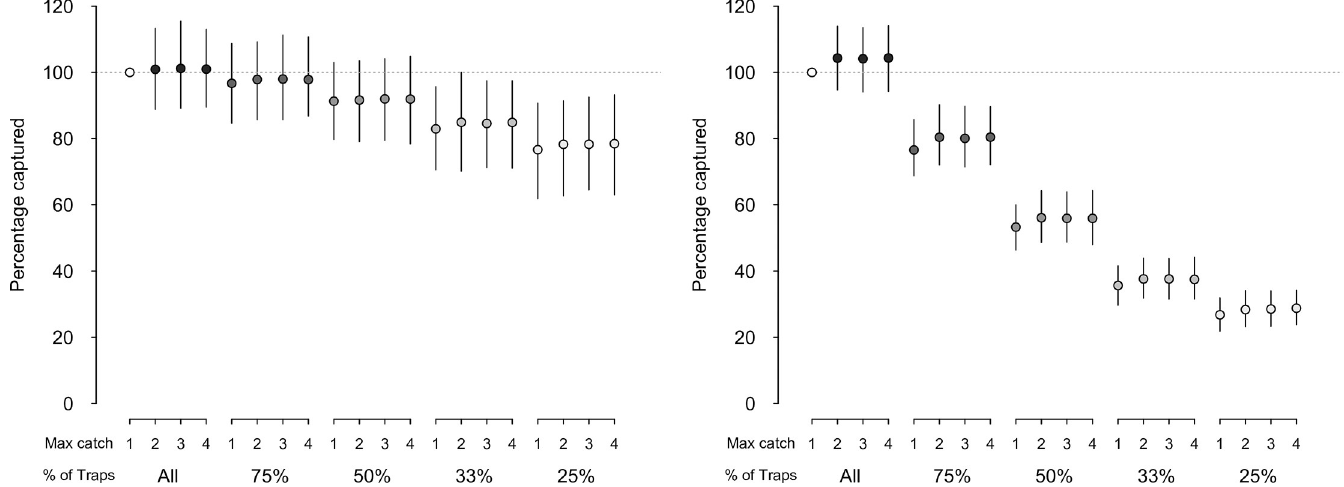
Fig 3. Simulated captures of predators (a) and non-target mammals (b) as a percentage of animals captured under the current trapping configuration. Data points represent the mean relative captures, over twelve one-month trapping sessions, for a range of trapping configurations, each expressed relative to a standard (100%) value of a single trap set per site with all available traps utilized. Vertical lines indicate the 5% and 95% percentile for each combination of the number of traps at each site (1 to 4) and the percentage of trap sites utilized (all, 75%, 50%, 33%, and 25%).